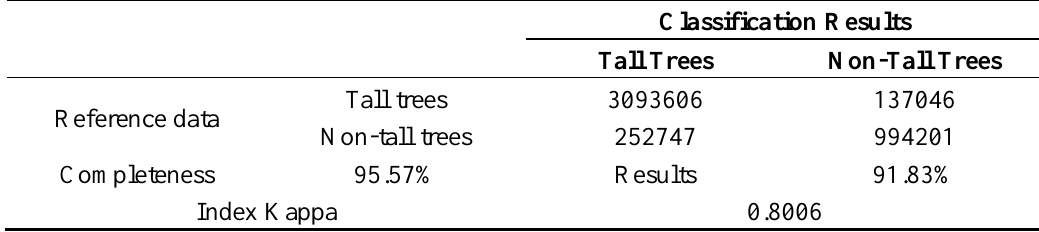
Table 4. The evaluation of the extraction of tall